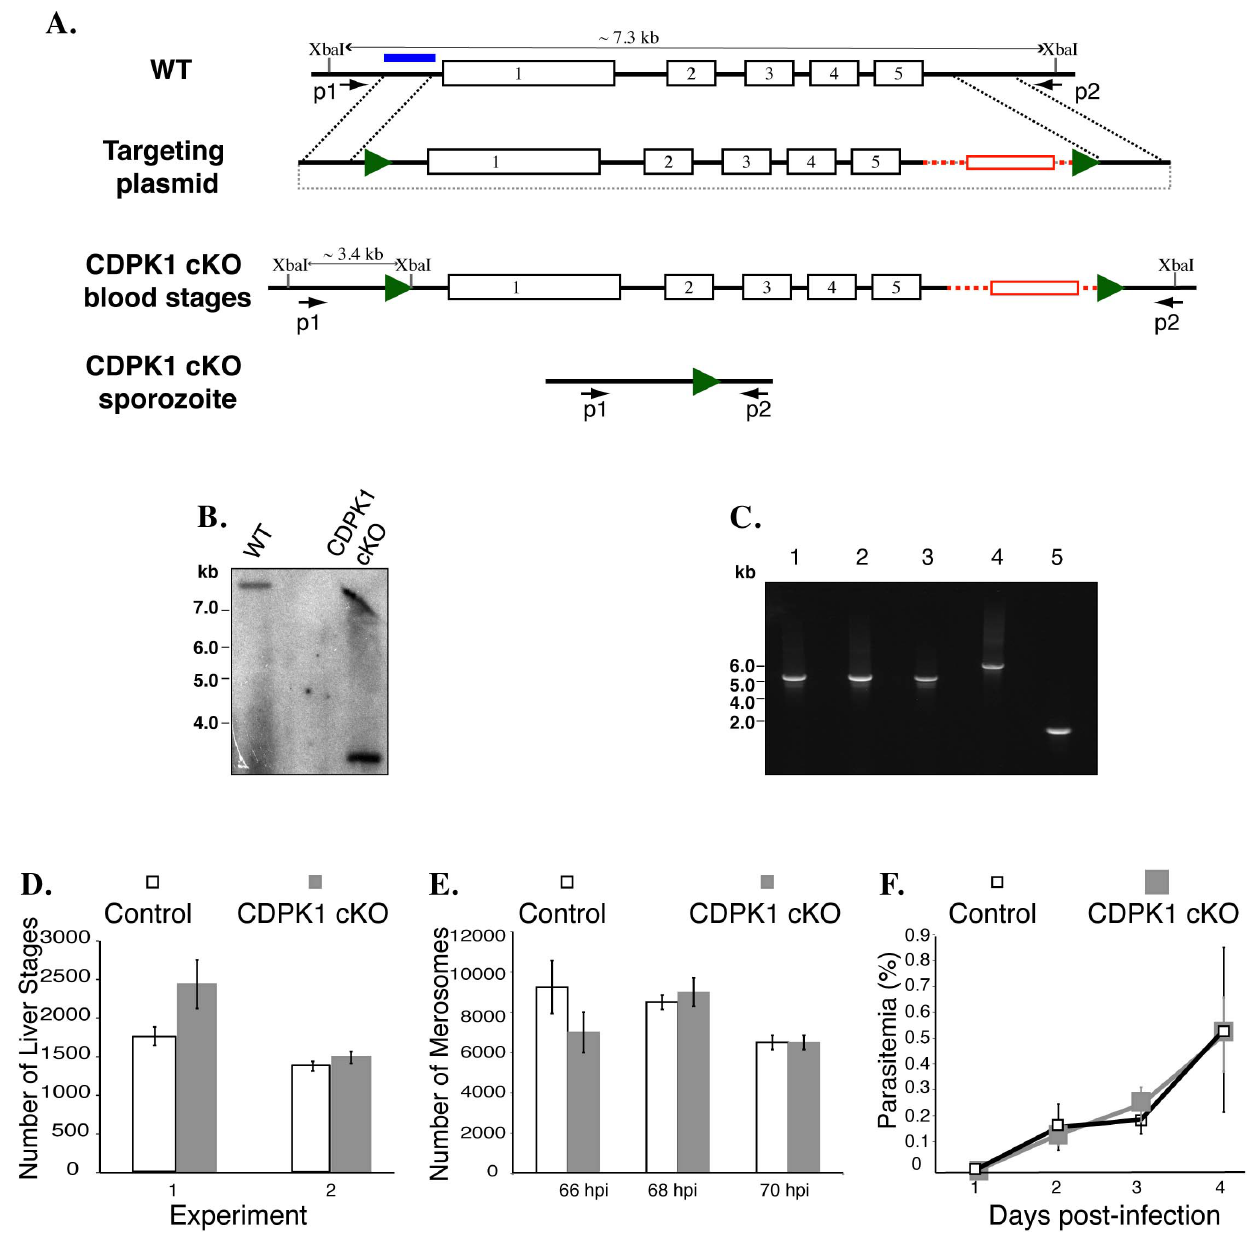
Figure 2. Conditional mutagenesis of PbCDPK1. (A) Schematic representation of the conditional mutagenesis of the PbCDPK1. (B) Southern hybridization demonstrating modification of the PbCDPK1 locus through the addition of FRT sites in FlpL/TRAP parasites. (C) PCR analysis using oligos p1 and p2, demonstrates excision of PbCDPK1 in genomic DNA obtained from (1) WT erythrocytic stages (2) FlpL/TRAP erythrocytic stages used for mosquito feeding (3) FlpL/TRAP erythrocytic stages recovered through bite infection from infected mosquitoes (4) CDPK1 cKO erythrocytic stages used for mosquito feeding (5) CDPK1 cKO erythrocytic stages recovered through bite infection from infected mosquitoes. (D) Intrahepatic development of CDPK1 cKO and control FlpL/TRAP sporozoites in HepG2 cells. Intracellular liver stages were quantified at 40–44 h p.i. (D) Parasite egress from infected HepG2 cells was monitored by quantifying the number of extracellular merosomes 66–70 h p.i. (E) In vivo infection of CDPK1 cKO and control FlpL/TRAP sporozoites was monitored by the appearance of erythrocytic stage parasites in mice infected through sporozoite injection.